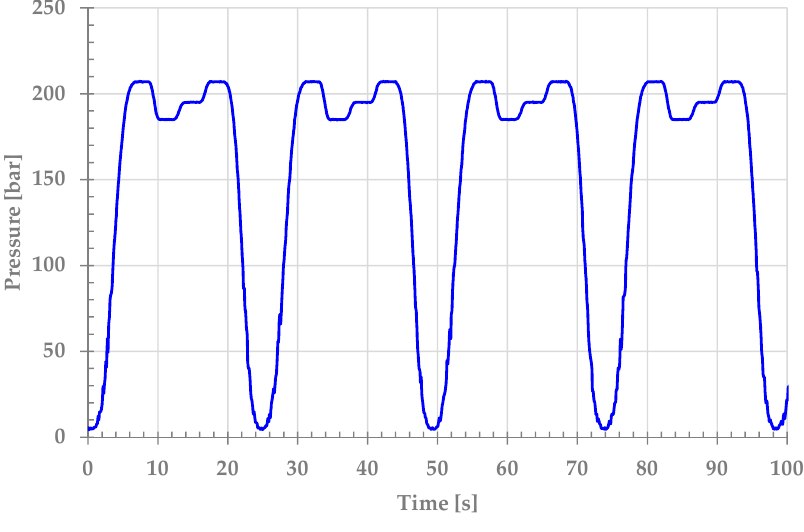
Figure 9. Endurance test spectrum.